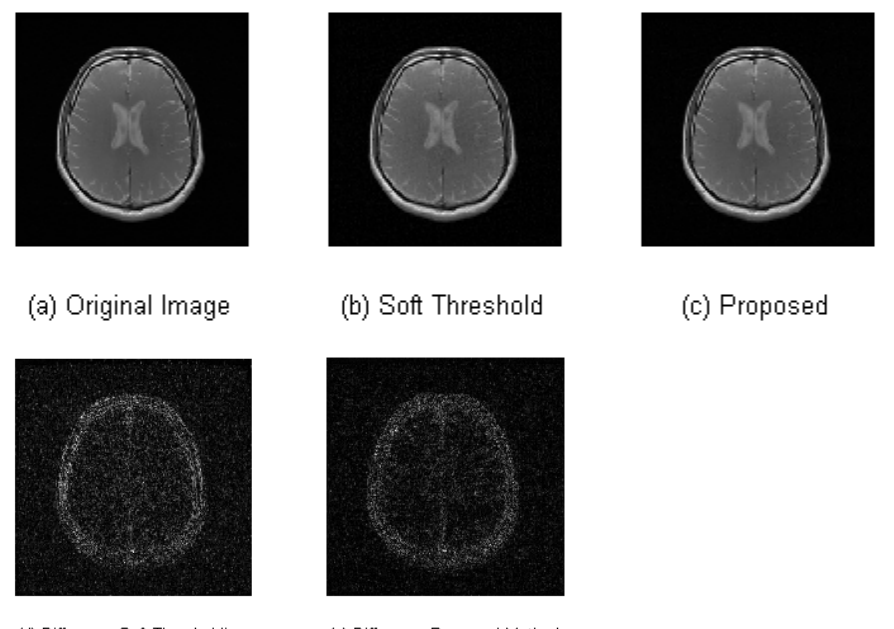
Figure 9. Correlation of proposed and soft thresholding algorithm of recovered compressively sam- ple MR image.